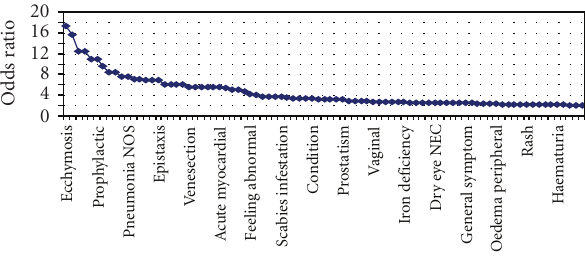
Figure 1: Medical conditions with OR significantly greater than 2 but less than 20. Table 4: Comorbidities at the PTL of the MedDRA classification and their 26